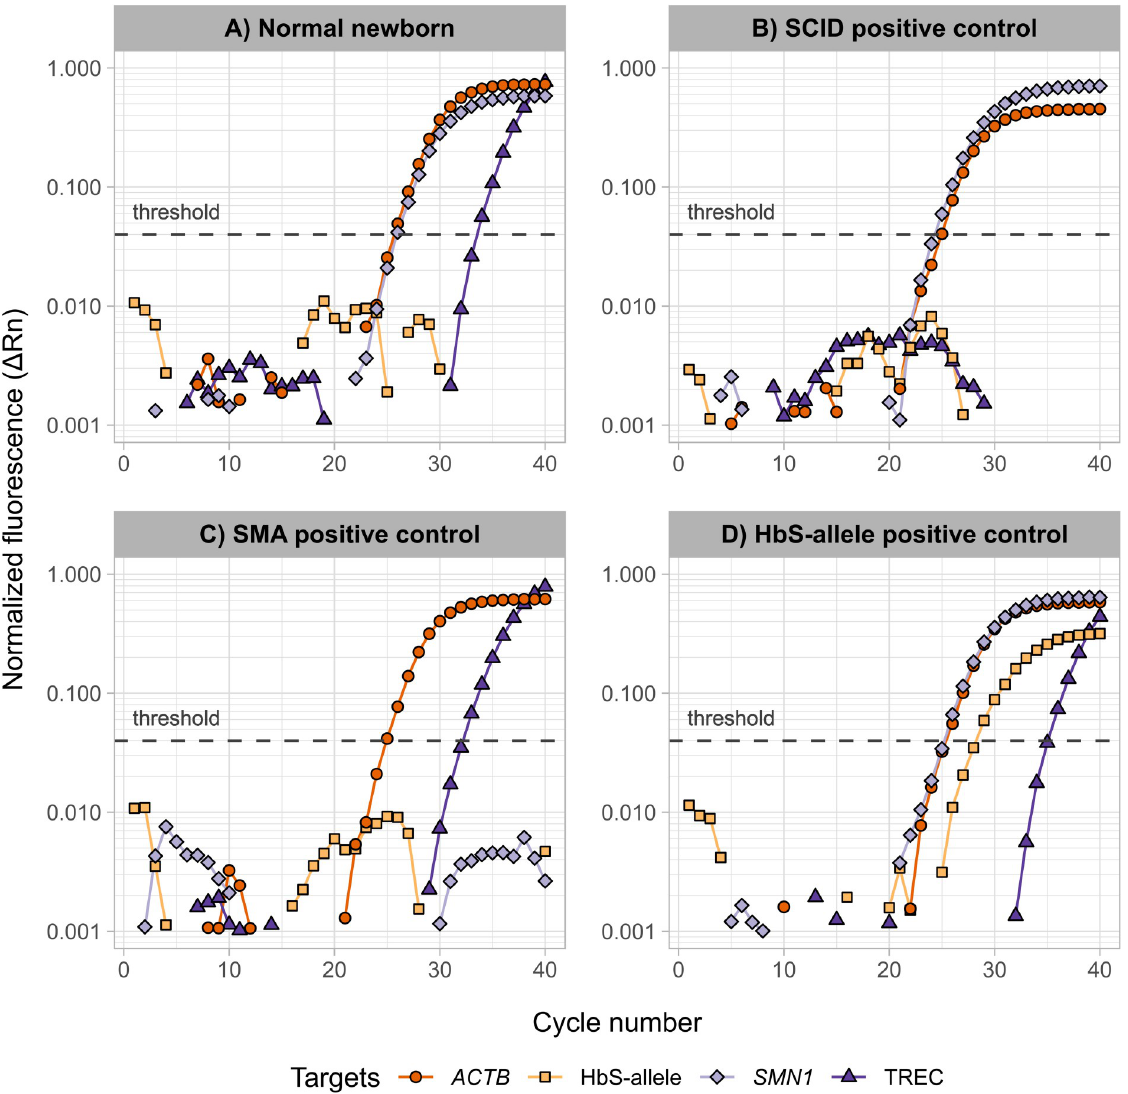
Fig 1. Amplification plots for the fluorescent probes representing the four targets ACTB , HbS allele, SMN1 , and TREC in samples of four different physiological conditions. (A) A normal newborn, or screening negative, sample showing a normal amplification of ACTB , SMN1 , and TREC, and no amplification of the HbS allele; (B) a reference SCID positive sample showing no TREC amplification; (C) a reference SMA positive sample with no SMN1 amplification; (D) a sample showing HbS amplification indicating the allele presence. The figure was created using R (v. 4.1.2), ggplot2 (v. 3.3.5), dplyr (v.